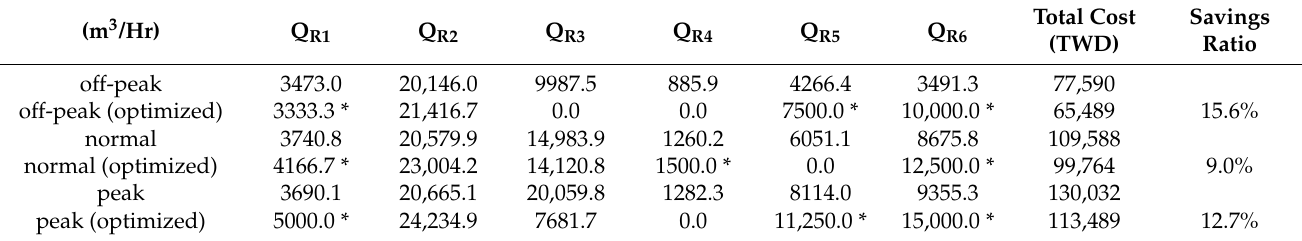
Table 7. Optimized water discharge for off-peak, normal, and peak periods at each